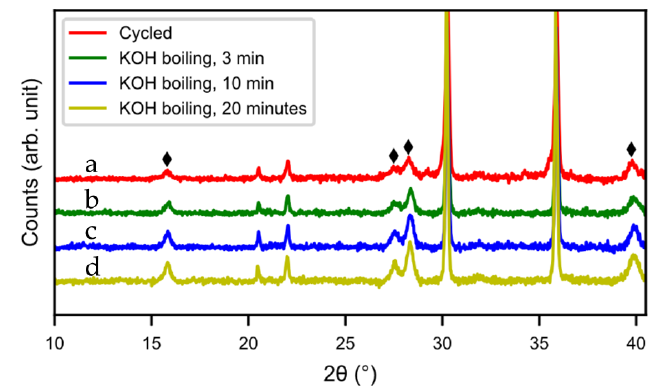
Figure 16. XRD patterns of alkaline-treated samples, ( a ) untreated, ( b ) t = 3 min, ( c ) t = 10 min, ( d ) t = 20 min. ( (cid:7) ) RE(OH) 3 . a, b, c, and d run from top to bottom